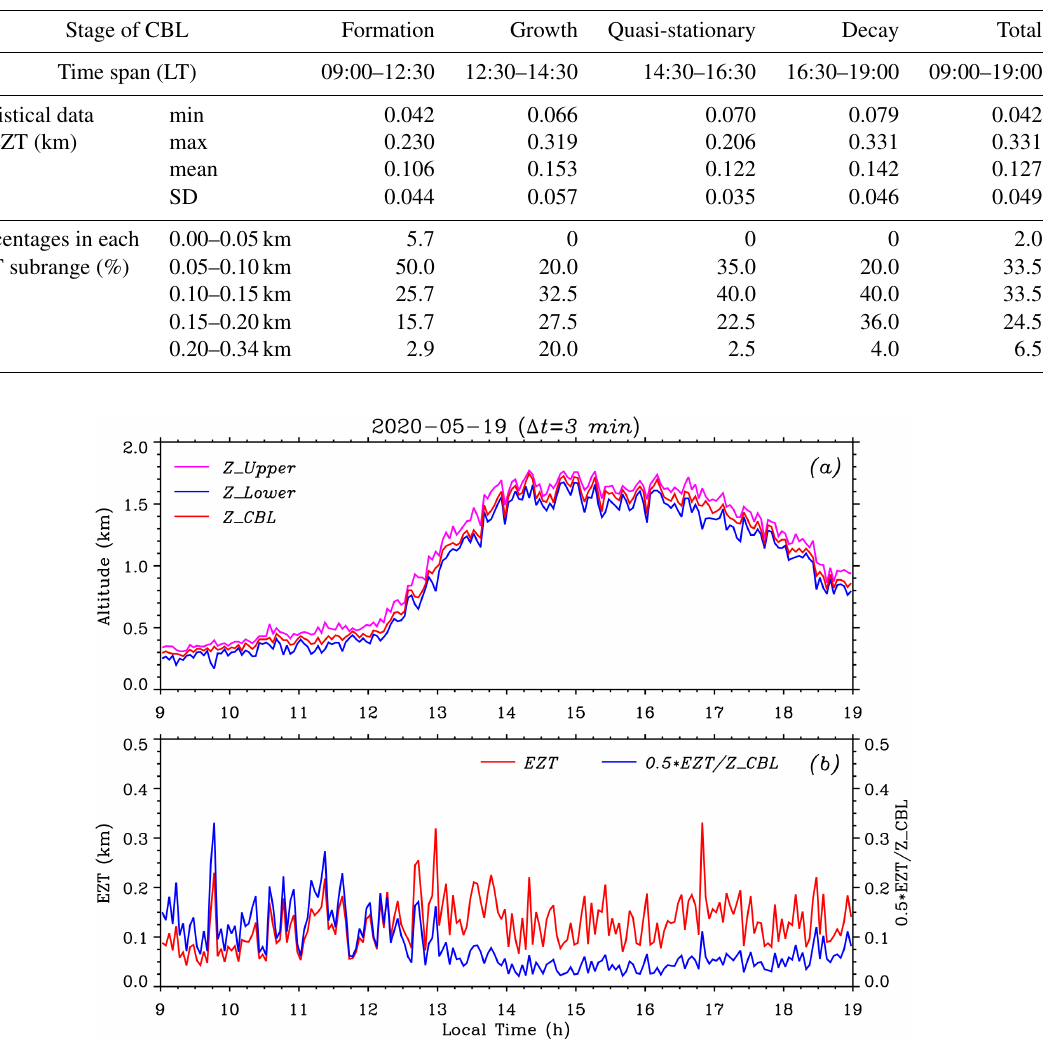
Table 2. Statistics of the EZT obtained on 19 May 2020.